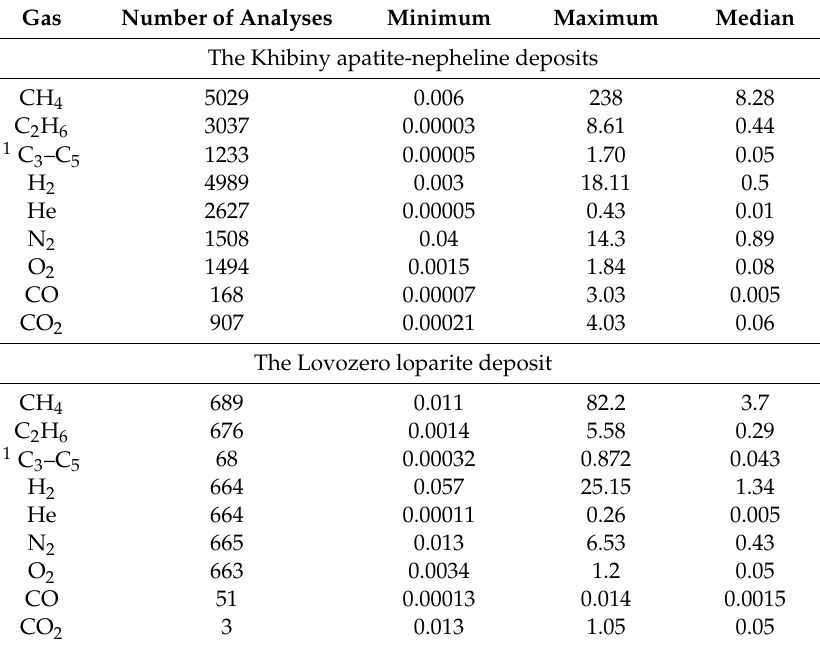
Table 1. Ranges and median contents of occluded gas (OG) components, cm 3 /